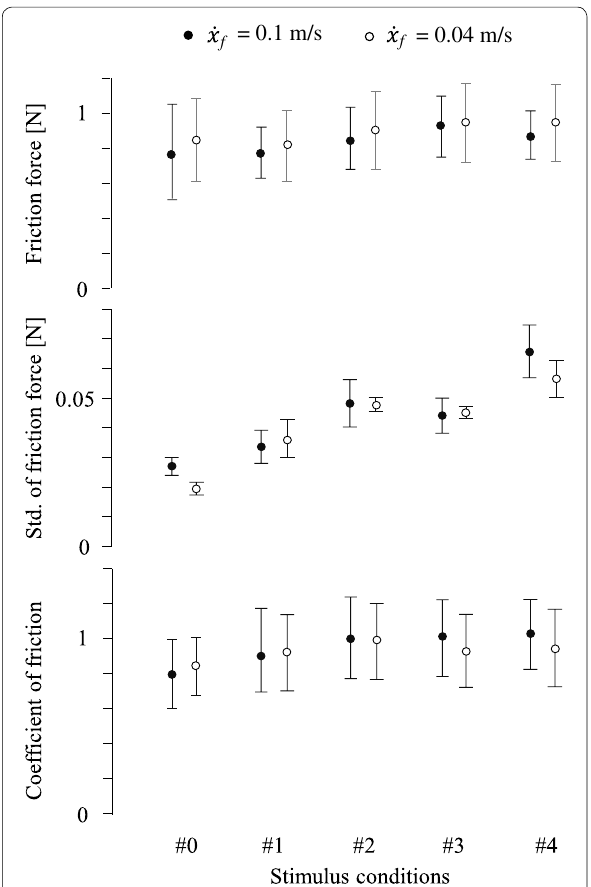
Fig. 10 Averages and standard deviations of friction forces and apparent coefficients of friction among all of the participants. Error bars are the standard deviations among the participants